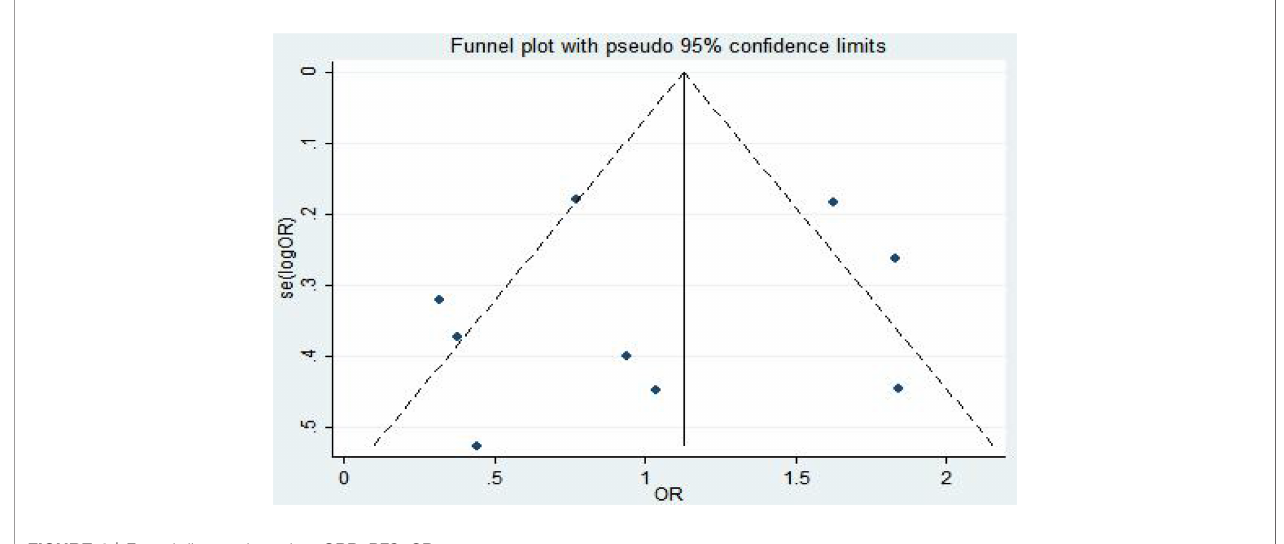
FIGURE 4 | Funnel diagram based on ORR, PFS, CR.